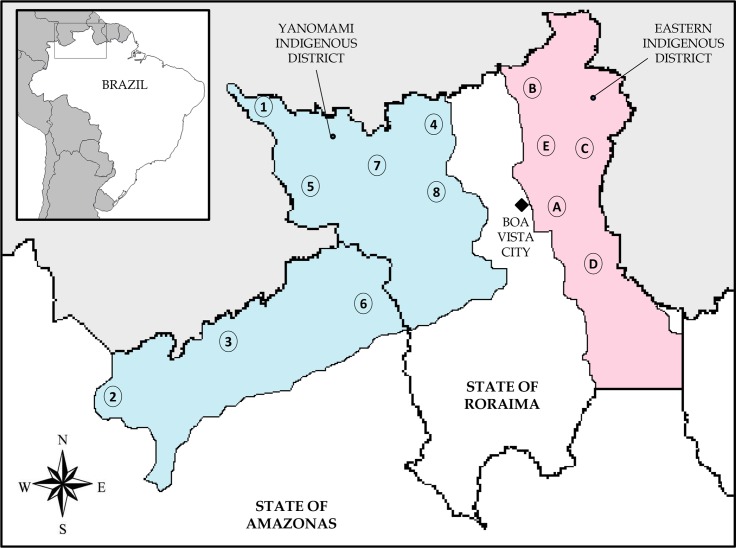
Representative map of the northern Amazonian region of Brazil.Geographical demarcation of the Eastern and Yanomami Indigenous Districts, Brazil, 2014. Location of the randomly selected villages, in order of visit. Yanomami District: 1-Auaris; 2-Maturacá; 3-Marari; 4-Ericó; 5-Surucucu; 6-Demini; 7-Palimi-ú; 8-Alto Mucajaí. Eastern District: A-Malacacheta; B-Camará; C- Vista Alegre; D-Pium; E-Boqueirão. This figure is similar but not identical to the original image, and is therefore for representative purposes only.